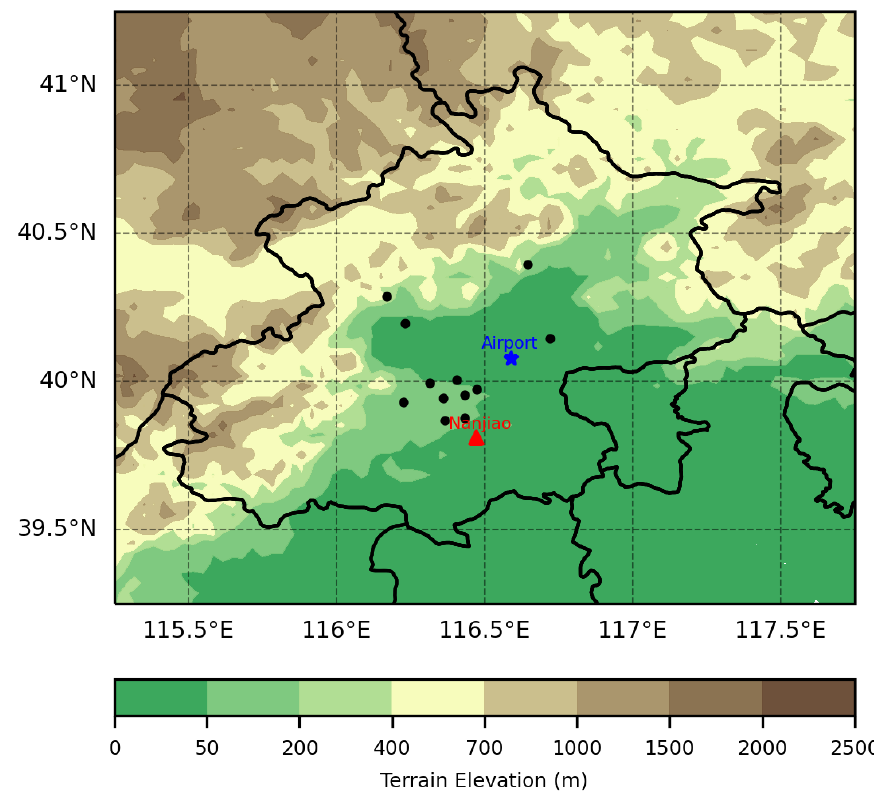
Figure 1. The location of Beijing airport (blue star), Nanjiao Meteorological Observatory (red triangle) and 12 sites operated by the China Ministry of Ecology and Environment (black dots). The color filling is based on terrain elevation.